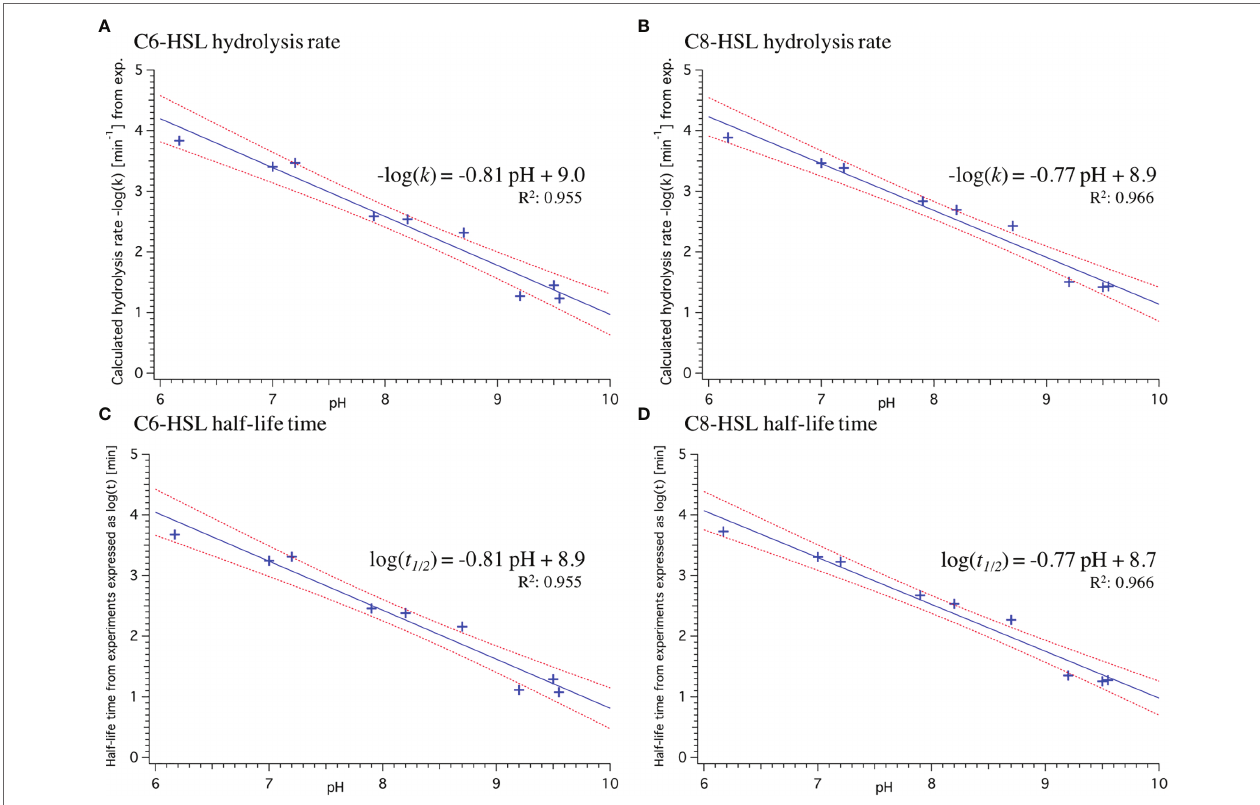
FIGURE 3 | pH-dependence of hydrolysis rate k (A, B) and half-life time t 1/2 (C, D) for C6- and C8-HSL with a pooled dataset including measurements from Decho et al. (2009) and temperature adjusted data from Ziegler et al. (2019) for which the kinetic isotope effect in D 2 O was accounted for. Linear least-square fit (blue line) yielded the respective equation. Red dashed lines indicate 95% confidence bands on fit and R 2 value indicates goodness of fit (the closer to 1 the better). Standard deviation of fit coefficients is specified in Table S6 .